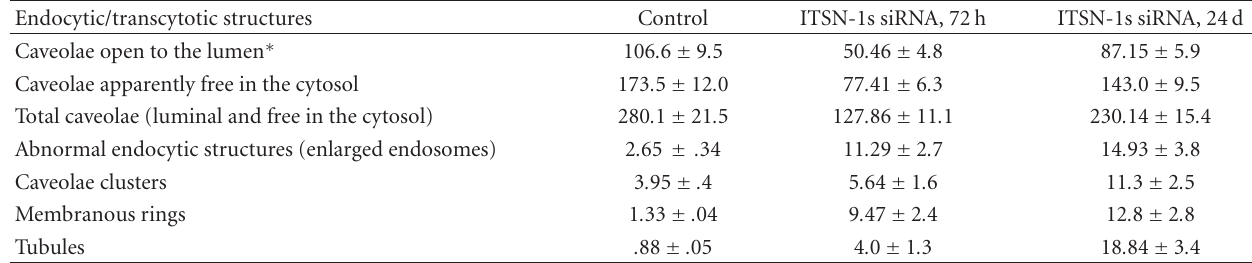
Table 1: Chronic inhibition of intersectin-1s expression causes the activation of alternative endocytic/transcytotic pathways and partially restores caveolae number.